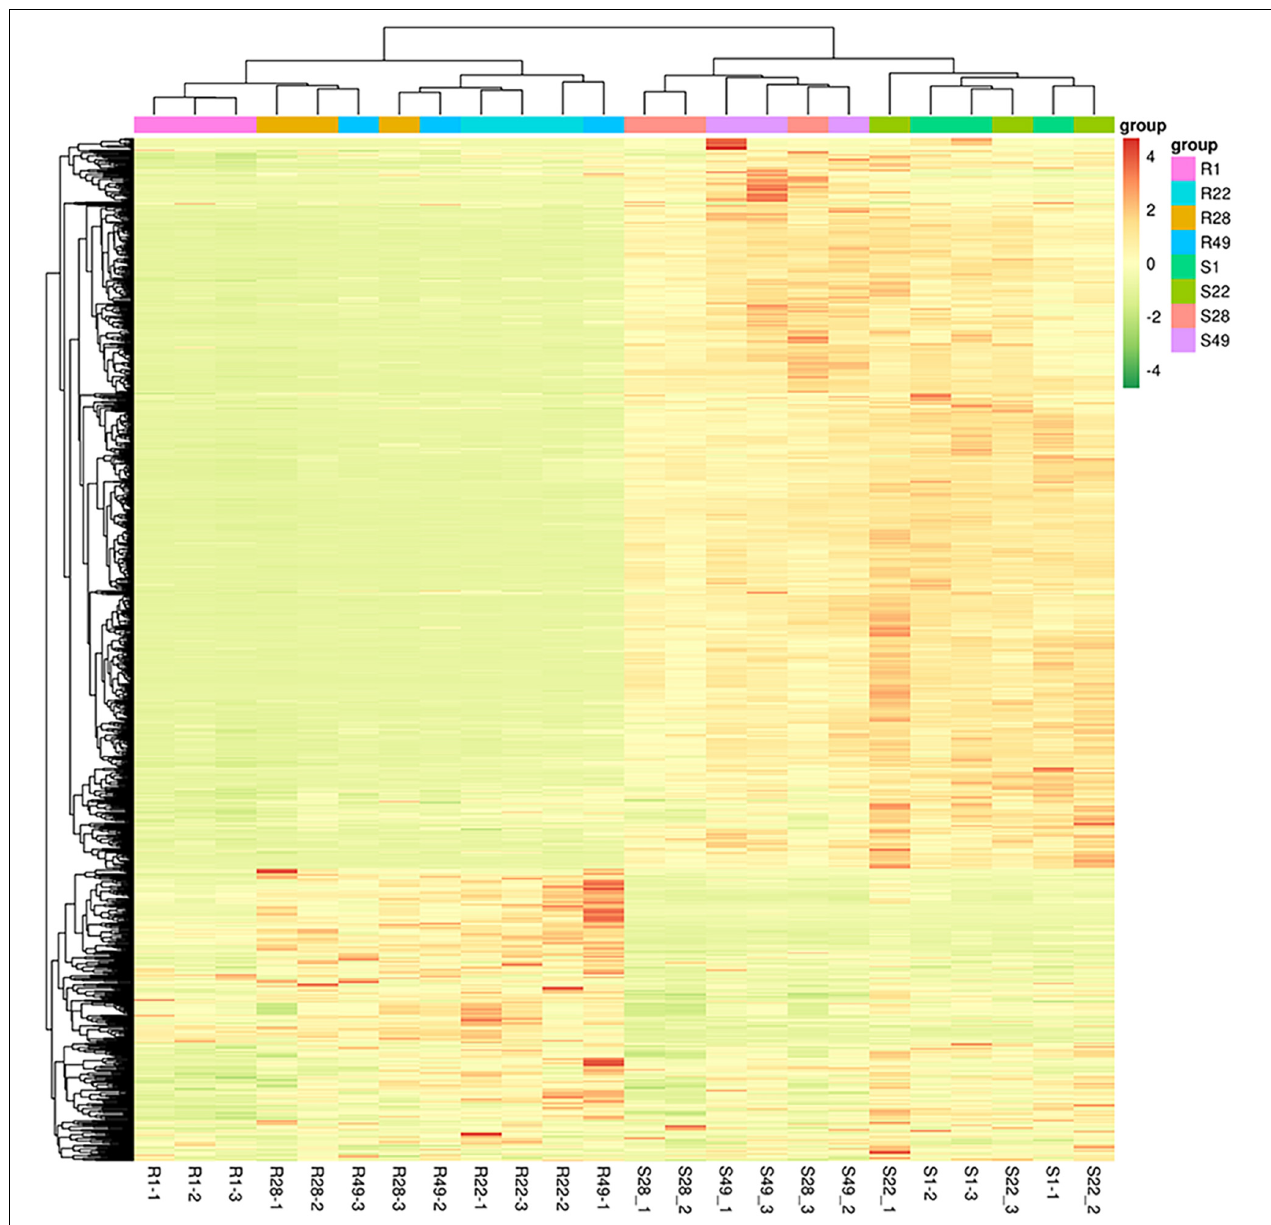
FIGURE 2 | Hierarchical cluster analysis of differential metabolites in tomato shoots (S1, S22, S28, and S49) or roots (R1, R22, R28, and R49). 1, Control; 22, Ri + Pf + Th; 28, Fo; 49, Ri + Pf + Th +